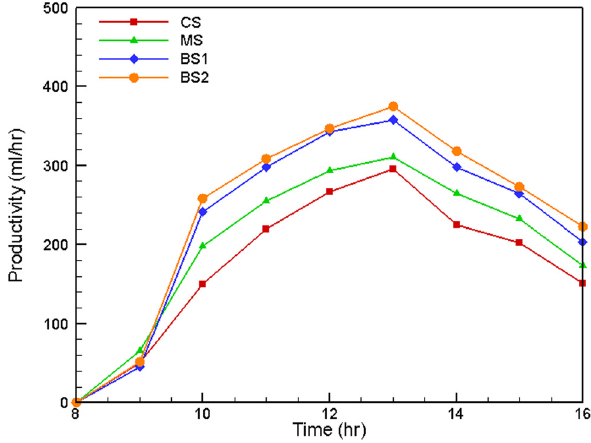
Figure 14: Variation of the productivity of fresh water with